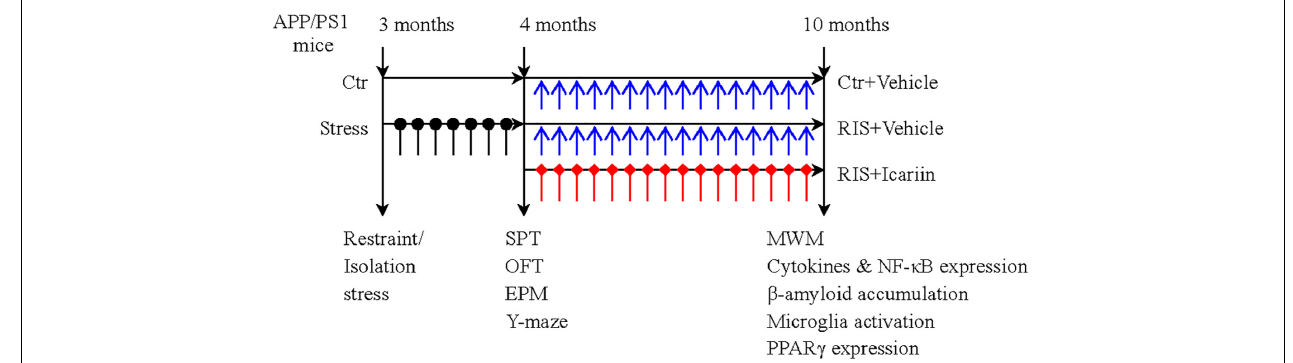
FIGURE 1 | The experimental paradigm. Thirty male APP/PS1 mice were randomly divided into three groups (10 mice per group): control group (Ctr), restraint/isolation stress group (RIS), and restraint/isolation stress + icariin group (RIS+ICA). Mice in both the RIS and RIS+ICA groups were subjected to 28 days of restraint/isolation stress procedure, from 3 to 4 months of age. Mice in the RIS+ICA group were administered icariin (60 mg/kg) daily for 6 months, from 4 to 10 months of age. The weight of the mice was recorded at baseline, every week during the stress procedure and every month during the period of drug administration. The behavioral tests performed after stress included the sucrose preference test (SPT), open field test (OFT), elevated plus maze (EPM) and Y maze test in this order. After drug administration, the Morris water maze (MWM) test was performed. Enzyme-linked immunosorbent assay and immunohistochemistry were used to assess the microglia phenotype and western blotting was used to measure the expression of PPAR γ in the hippocampus and PFC.